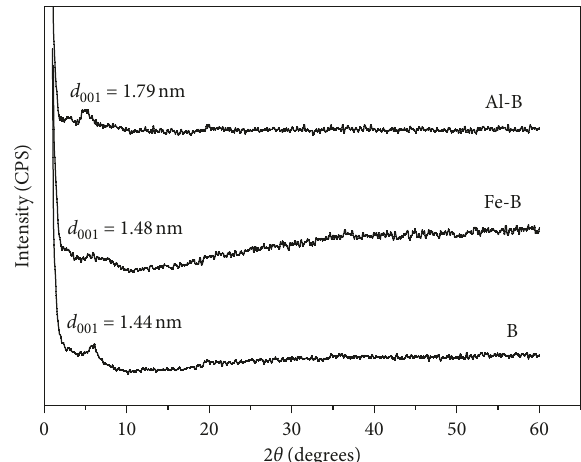
Figure 1: XRD patterns of B, Fe-B, and